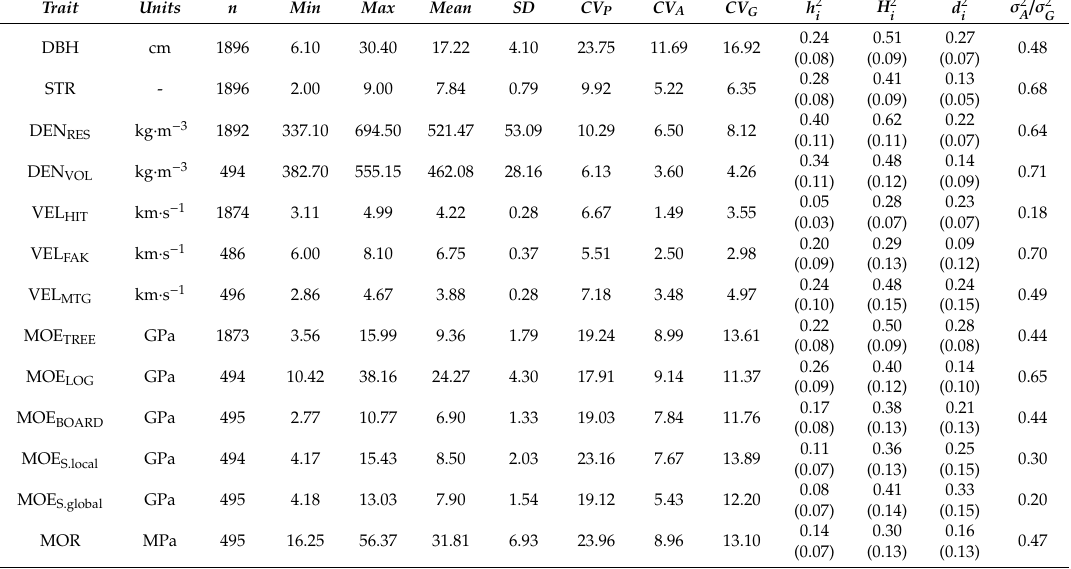
), and broad-sense ( H 2 ) heritability, dominance ratio ( d 2 i i / σ 2 ) (standard errors are in parentheses). A G